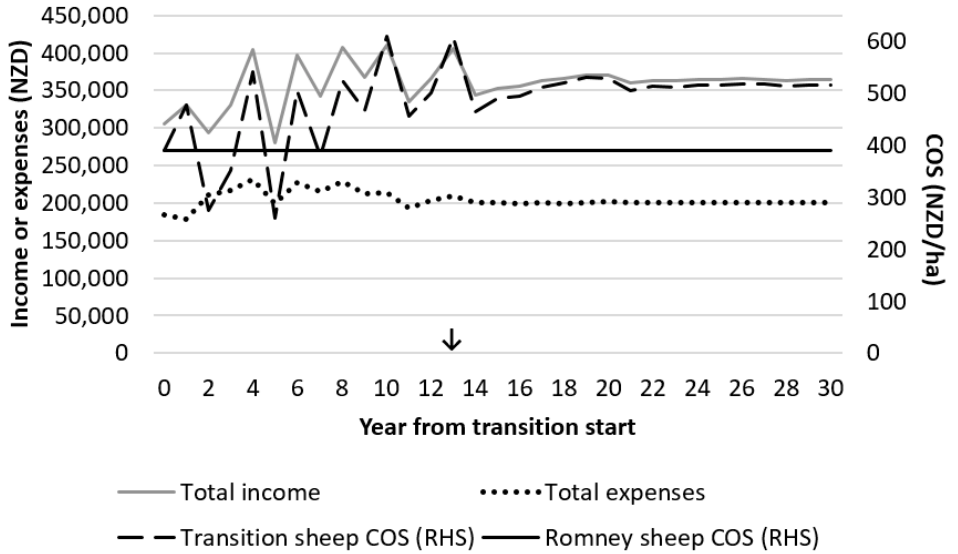
Figure 6. Sheep enterprise income, expenses, and cash operating surplus (COS on the right hand side y axis) during a grading up transition. Sheep enterprise COS (on the right hand side y axis) from the original Romney flock is also displayed. ↓ indicates where the 3 / 4 Merino 1 / 4 Romney flock has reached the same annual feed demand as the base Romney flock. Table 5. Net present values of modelled scenarios of maintenance of the status quo Romney flock with the change (%) in NPV for a whole flock grading up transition to 3 / 4 Merino 1 / 4 Romney. Sheep and wool sale prices were either at a base 2017/18 level, or changed by ± 10% in a sensitivity analysis. Net present value analyses were conducted over 14 (transition period) and 30 years (time taken to reach stable ewe numbers in the 3 / 4 M 1 / 4 R flock). Discount rates of 6% and 10% were used to reflect 2017/18 and long-term New Zealand lending interest rates, respectively